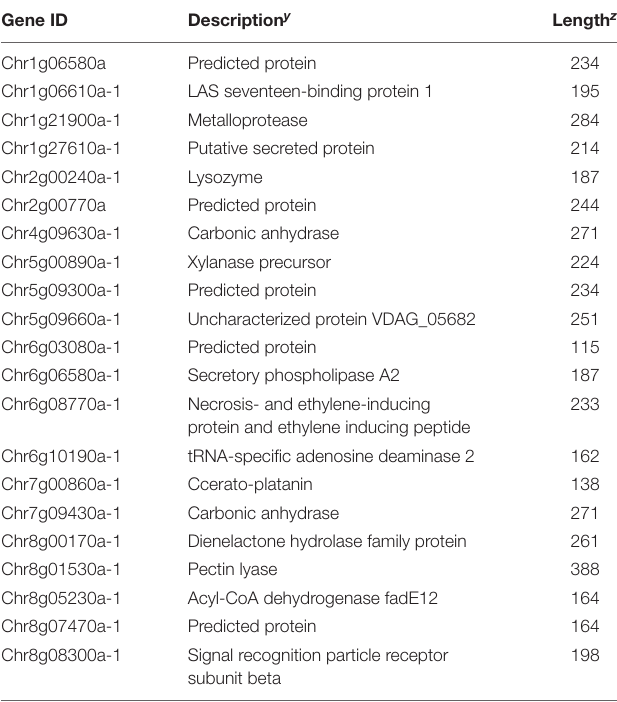
TABLE 3 | Core effectors (Classes 1 and 2) conserved in V. dahliae, V. alfalfae and V. longisporum